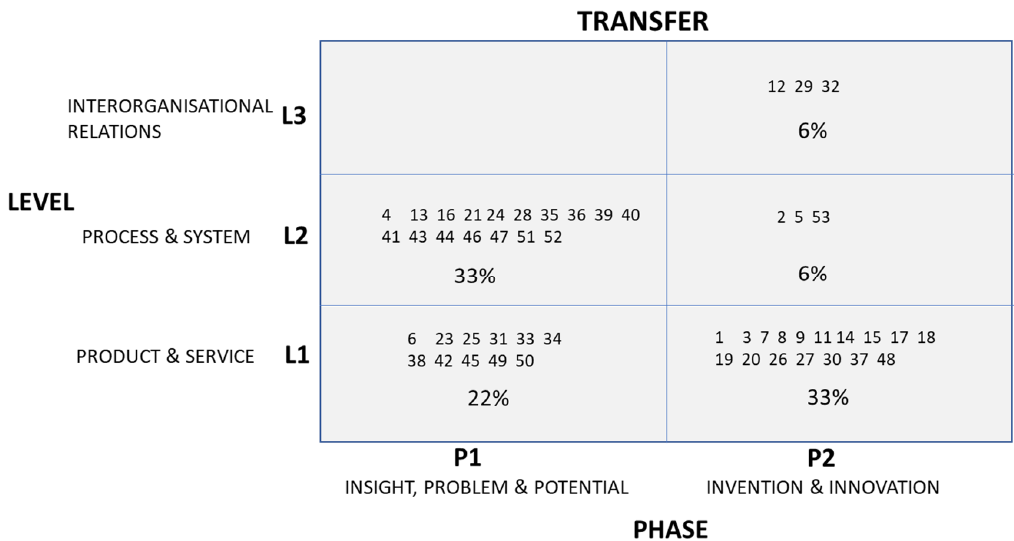
Figure 11. Coding of articles according to phase and level. Each article is numbered, where the lowest number corresponds to the highest citation rate.